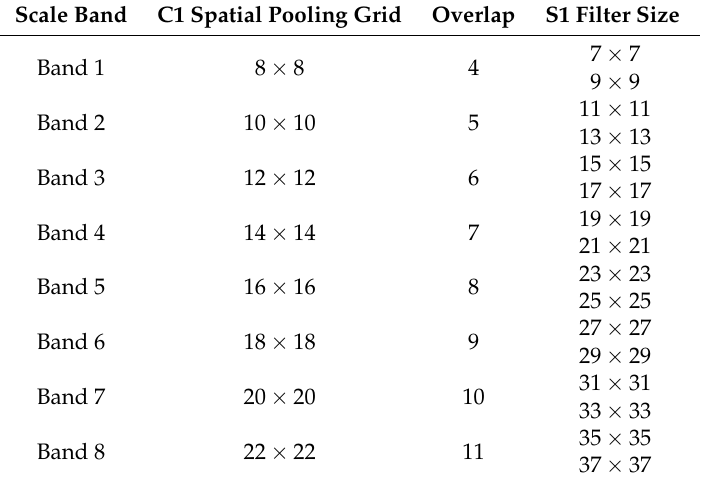
Table 1. Summary of the S1 and C1 layer parameters. The filter sizes of S1 layer range from 7 × 7 to 37 × 37 with a step size of 2, leading to 64 different receptive fields in total (4 orientations × 16 scales). C1 layer pooling sizes spread from 8 × 8 to 22 × 22 with a step size of 2 corresponding to the S1 layer scale bands. Scale Band C1 Spatial Pooling